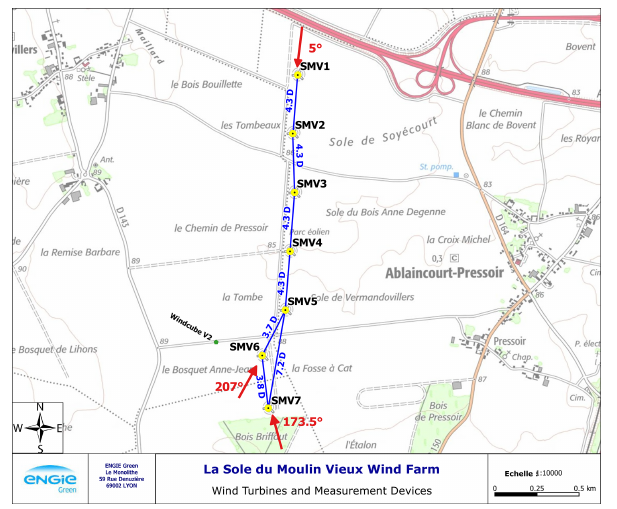
Figure 1. Layout of SMV wind farm. Distances between wind tur- bines (normalized by their rotor diameter D = 82m) and directions related to SMV6 and SMV5 are also shown. The location of the Windcube v2 sensor used for field campaign 2 is also indicated.